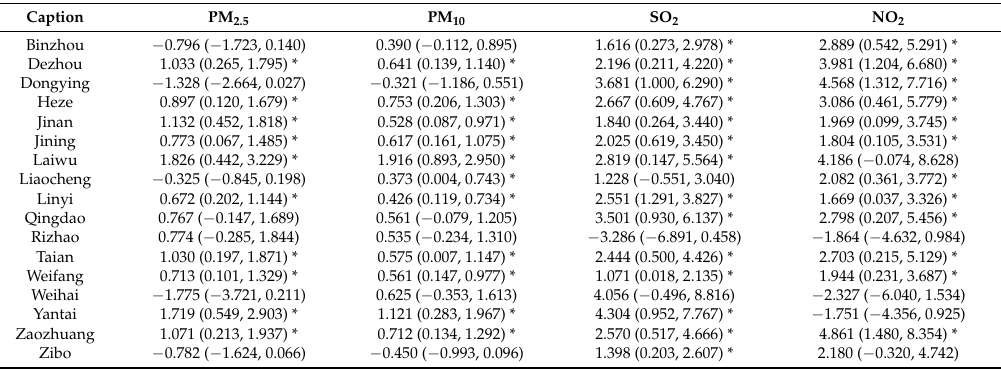
Table A9. Percentage changes of the relative risk of female COPD hospitalizations and their 95% confidence interval (CI) per 10- µ g/m 3 increase in air pollutants in the 17 cities of the Shandong province, where * indicates statistically significant estimates ( p <